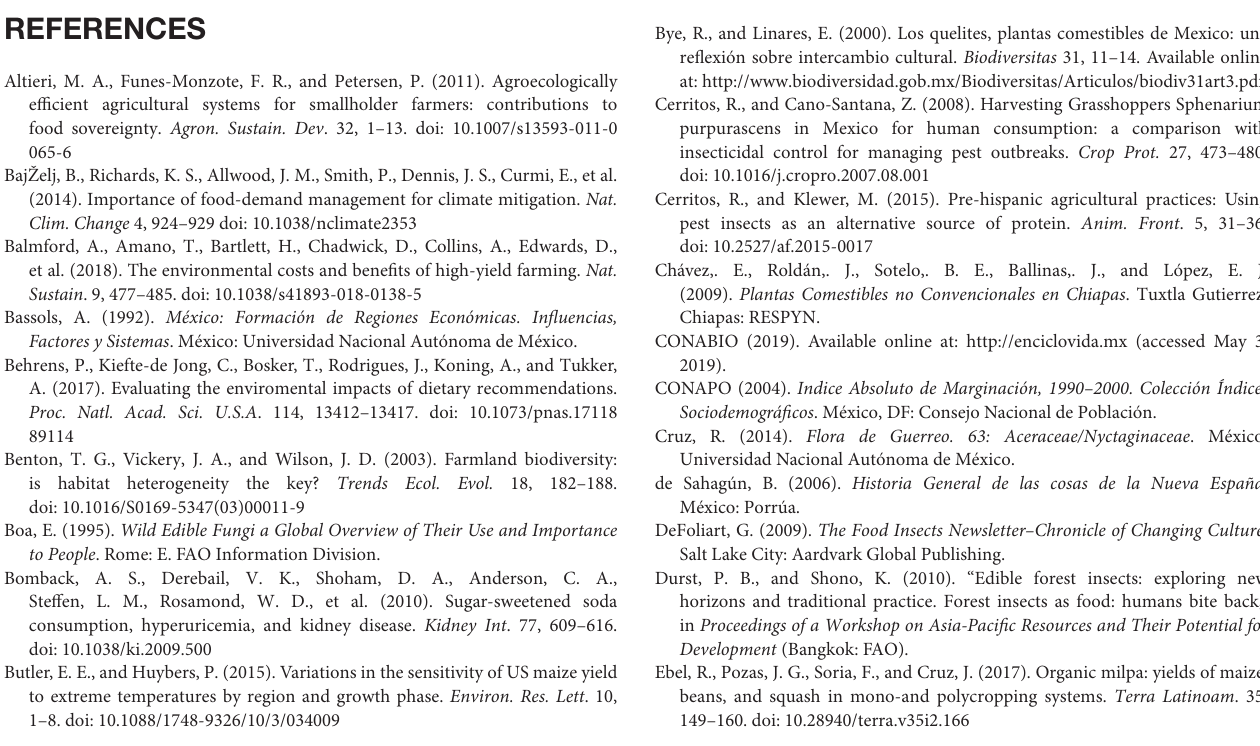
Supplementary Table 1 | Edible species list. Supplementary Datasheet 1 | Information from FAO and WHO